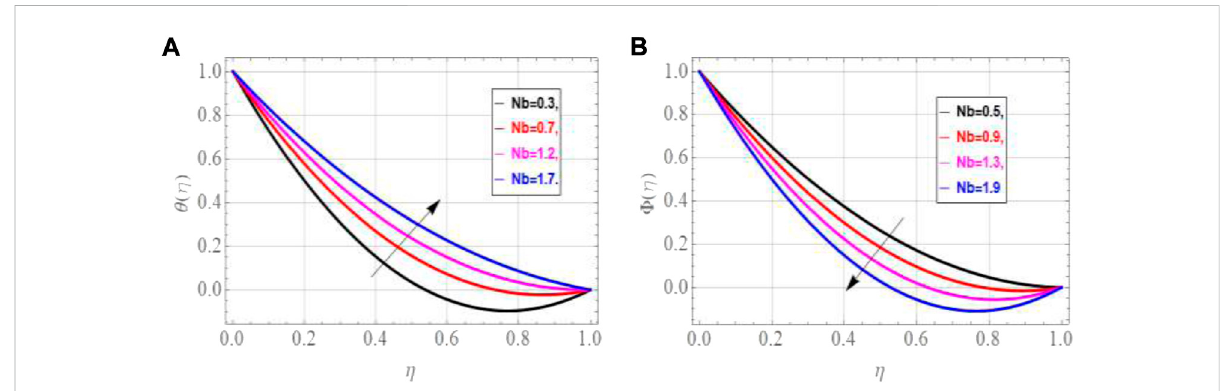
FIGURE 6 Impact of Nb on θ ( η ) , Φ ( η ) .